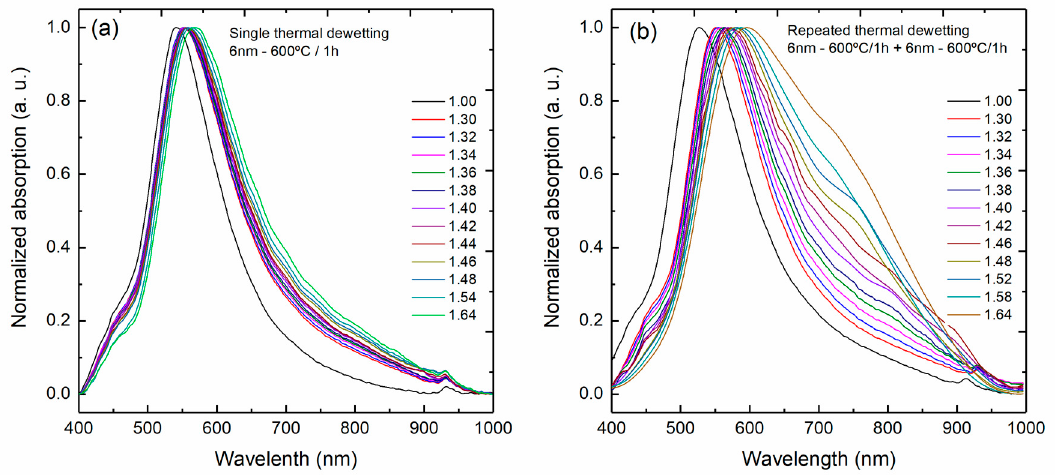
Figure 11. Evolution of the absorption spectra from 400 to 1000 nm as a function of the refractive index of the surrounding medium from 1.30 to 1.64 of multimode silica optical fibers coated with a 6 nm of gold and fabricated at 600 °C for 1 h by ( a ) single step and ( b ) repeated dewetting.